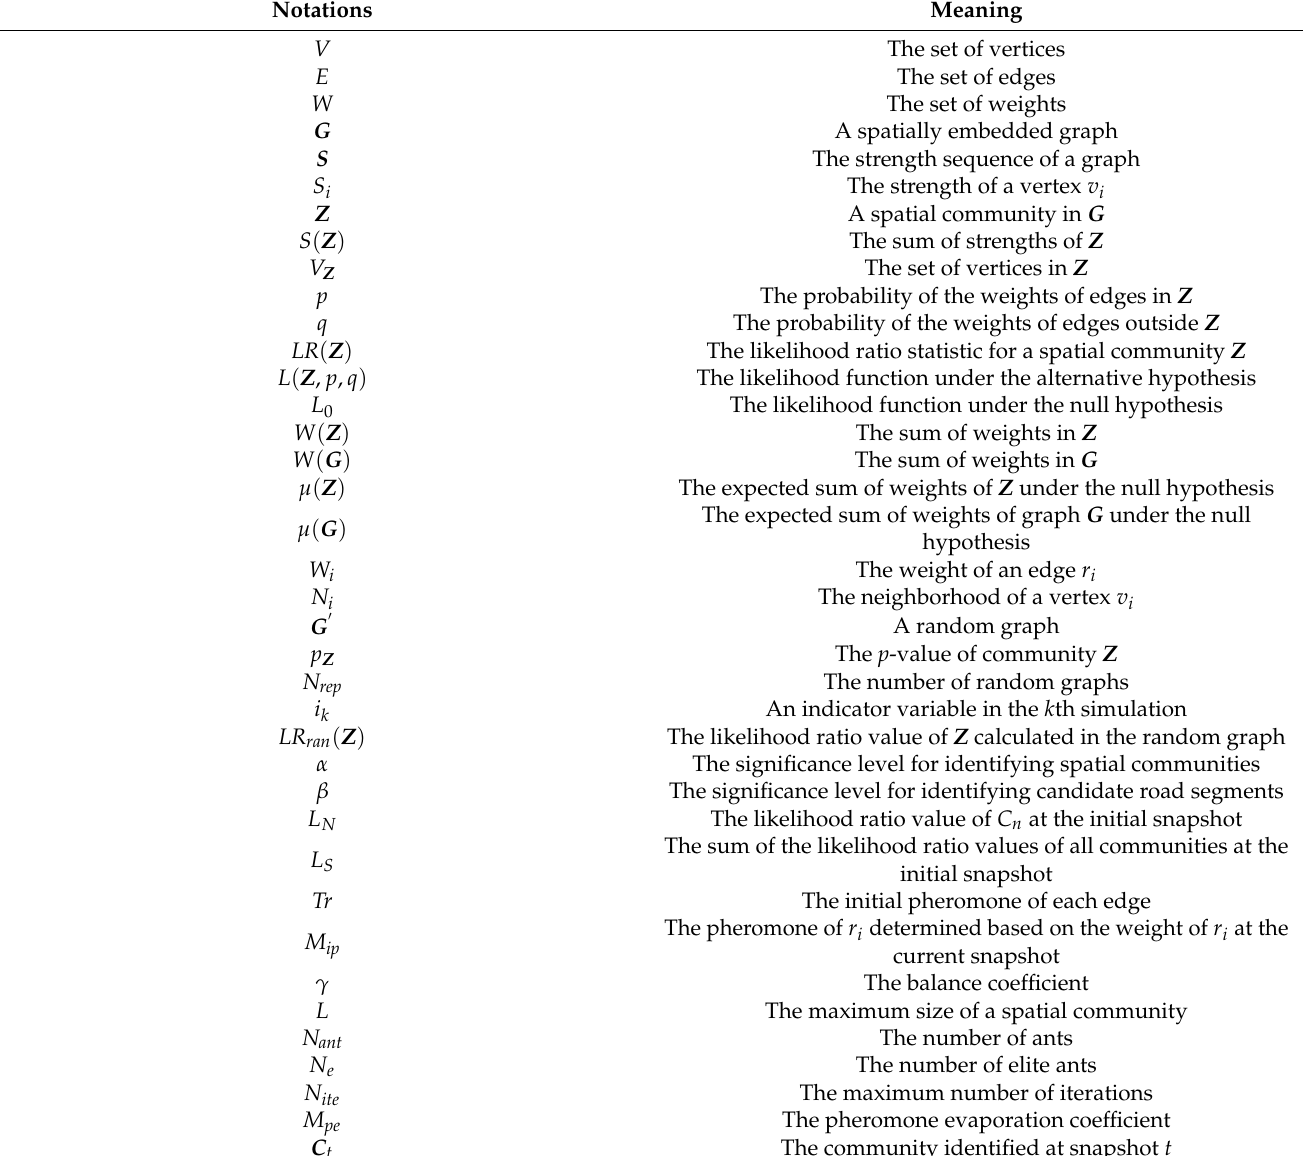
Table 1. Main notations used in this